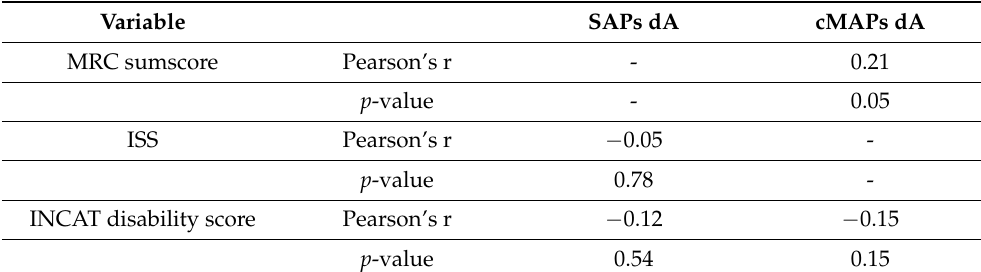
Table 4. Pearson’s